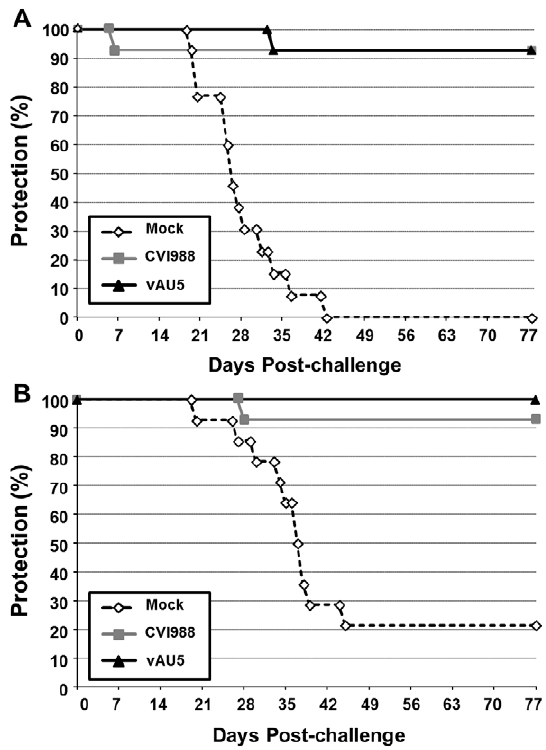
Figure 7. Immunization with the vAU5 mutant viruses protects chickens from lethal MDV infection. A) MD-incidence in N2a (A; n=14) and B) P2a (B; n=14) chickens vaccinated with either vAU5, CVI988 or media alone (Mock) before challenge-infection with RB-1B. Precent protection from the onset of disease or being tumor-positive at termination of the experiment is shown in % of the